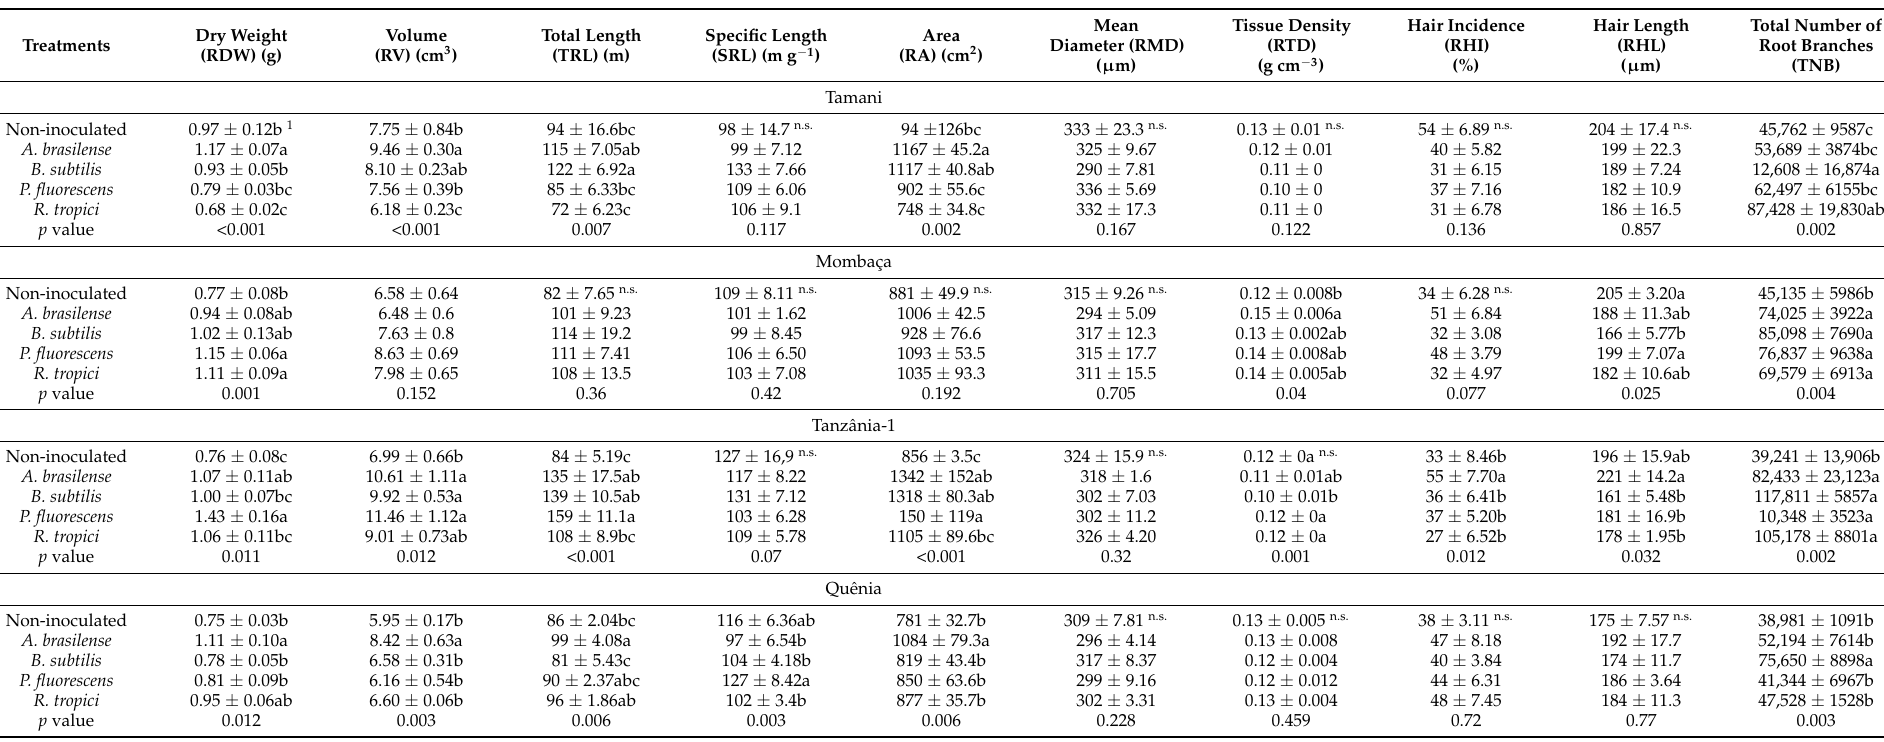
Table 1. Root growth traits of six Megathyrsus maximus cultivars (Tamani, Mombaça, Tanz â nia-1, Qu ê nia, Massai, and Zuri) either inoculated with